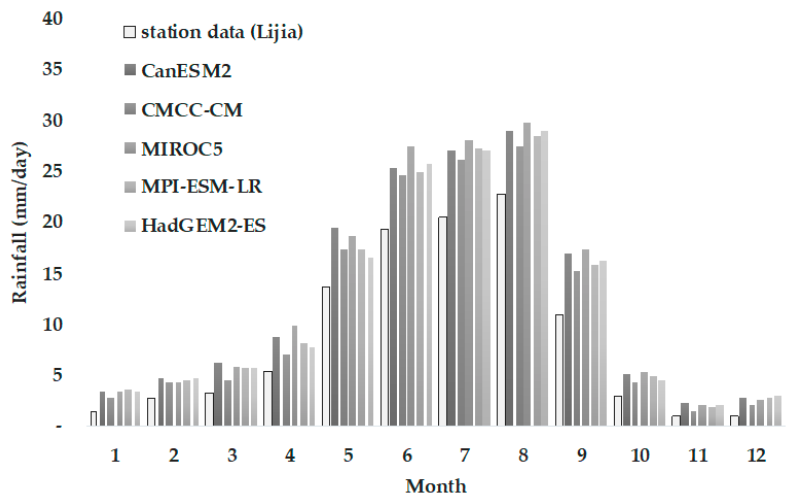
Figure 8. Bias correction result in rainfall of the No-Threshold method.